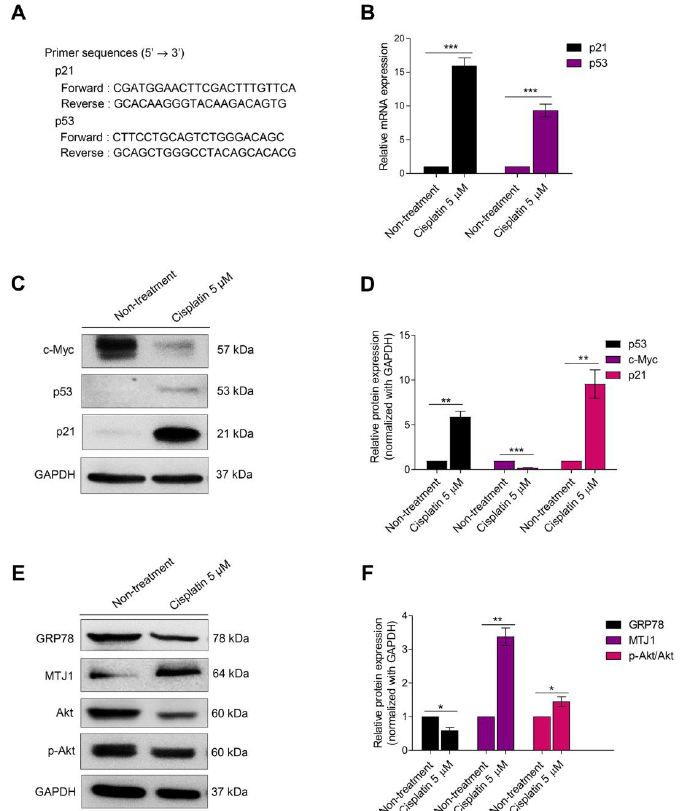
Figure 2. ( A ) The sequences of p53 and p21 for RT-PCR were presented. ( B ) mRNA levels of senes- cence-related markers, p53 and p21, were examined in H460 and cisplatin-treated cells. Relative mRNA expression levels were calculated compared with non-treated control. ( C ) Western blot anal- ysis was performed to confirm the senescence-related proteins, c-Myc, p53, and p21, in H460 senes- cent cells when H460 non-treated cells were used as the control. GAPDH was measured to normal- ize the equal loading of each protein sample. ( D , F ) The densitometry of each protein level was demonstrated as a relative protein level. ( E ) To evaluate the GRP78 expression which associated with cellular senescence, MTJ1, which is the essential heterodimer of GRP78 and downstream pro- tein of GRP78, was evaluated by Western blot analysis. The GAPDH protein was examined to con- firm equal loading of each protein sample. Data represent the mean ± SEM ( n = 3) (* 0.01 ≤ p < 0.05, ** 0.001 ≤ p < 0.01 and *** p < 0.001, compared with the non-treated